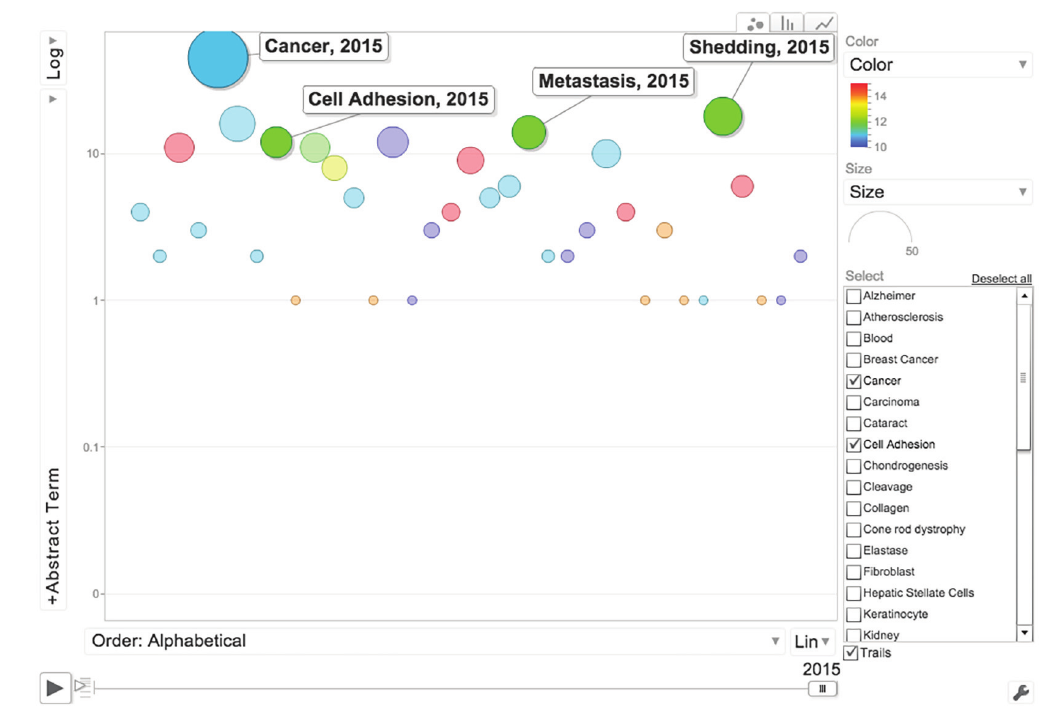
Supplementary Figure 1. ADAM9 Literature Profile. This bubble graph indicates the frequency of abstracts of papers published on ADAM9 containing curated terms (Y-axis: Abstract Term) as of January 2015. Terms are ordered alphabetically along the X-axis. The colors indicate different categories (Blue: Cell type, Green: Disease, Red: Tissue, Light blue: Cellular component, Yellow: Function. The size of the bubbles is proportional to the number of abstract terms. (Interactive version: Additional file iFIGURE 1 - X-axis drop down menu, select “Order: Alphabetical”; Y-axis drop down menu, select Log Scale; Click “Play” (bottom left corner))